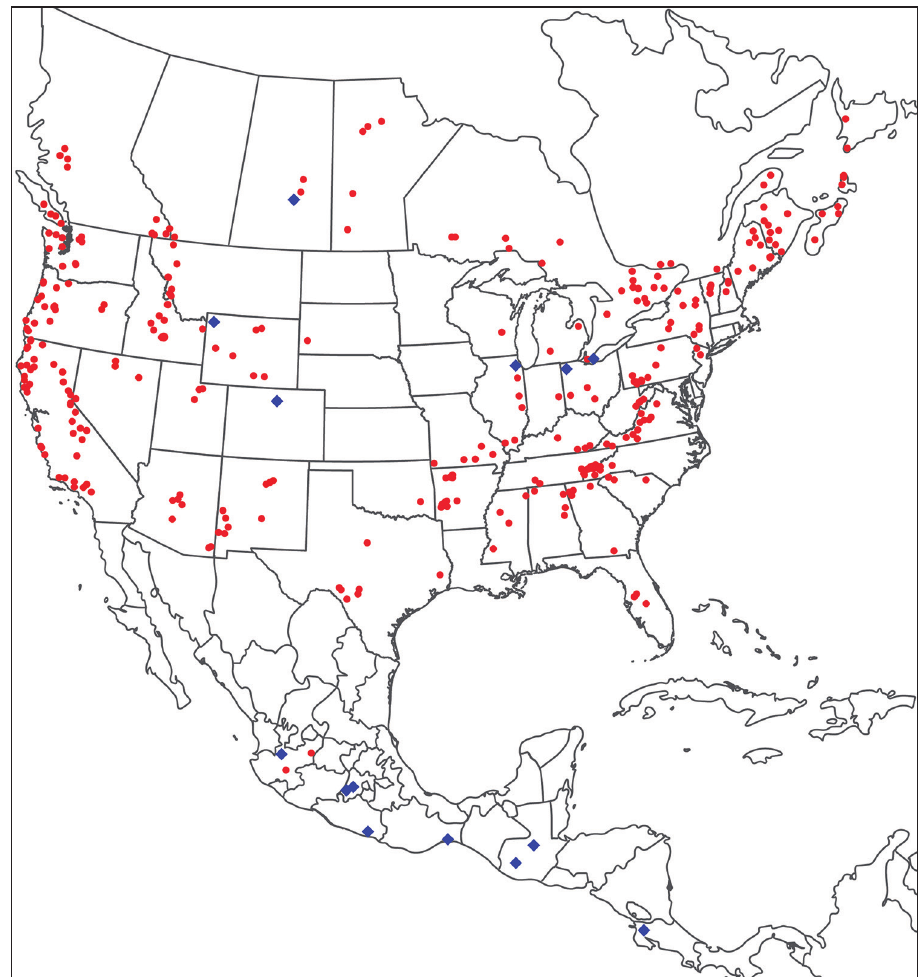
Figure 2. Summary of all sampling localities. 327 red dots represent material examined; 14 blue dia- monds represent published accounts where material was not available for direct examination. Each of the 341 localities represent a generalized locality, not an individual collection event, as multiple events often occured in close proximity. In total, this map represents nearly 500 collection events. Note the absence of material from the Great Plains (e.g., Oklahoma, Kansas, Nebraska, and the Dakotas) and Alaska; these are areas that were sampled for water mites, but Torrenticola were not